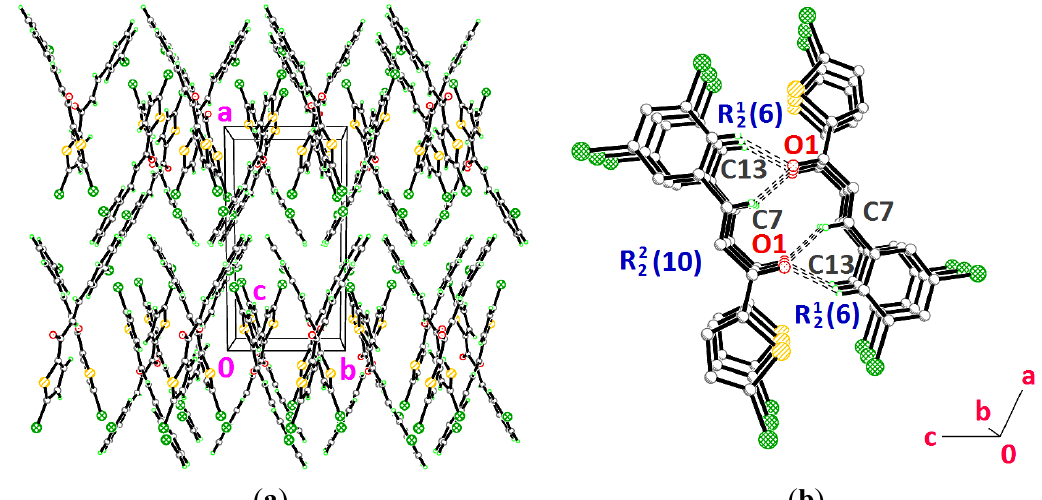
Figure 10. Crystal structures of ( a ) 3g viewed along the c -axis ( b ) 3h viewed along the b -axis. Dashed lines indicate the intermolecular hydrogen